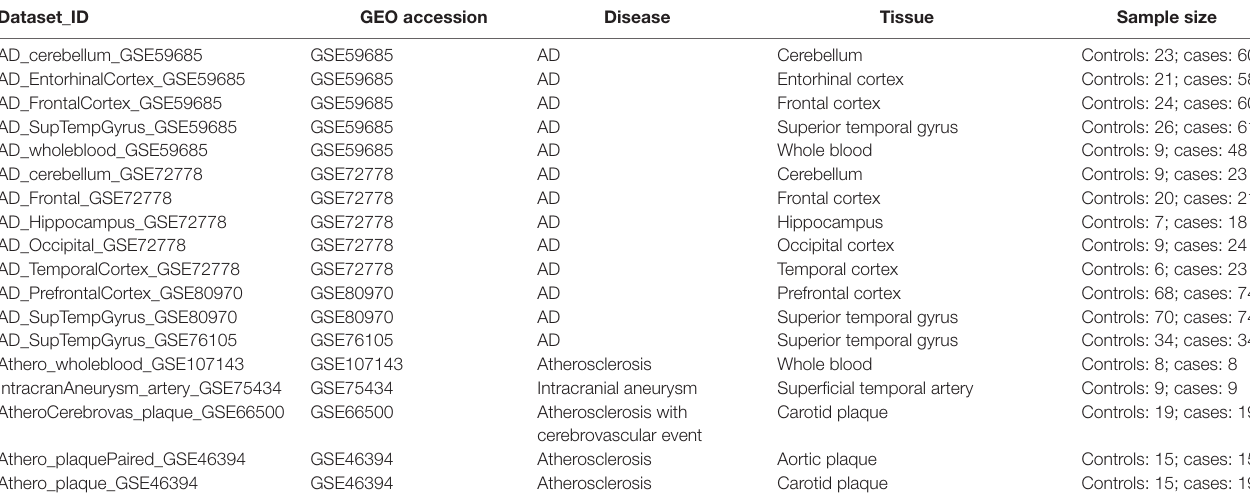
TABle 1 | Gene Expression Omnibus methylation datasets of Alzheimer's